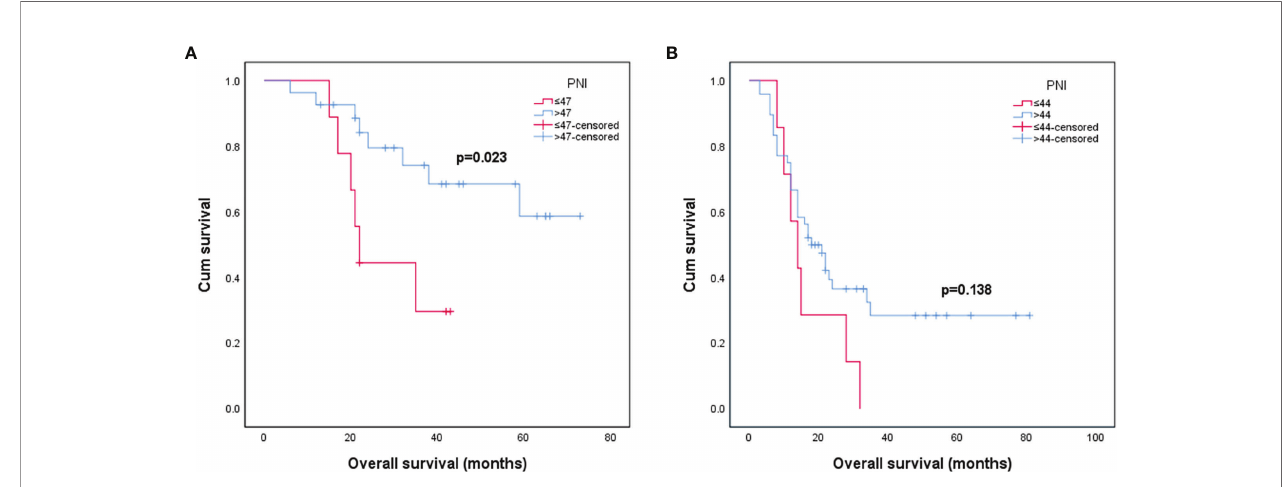
FIGURE 1 | Kaplan – Meier survival curves for patients strati fi ed based on preoperative PNI in patients with grade III glioma (A) and patients with grade IV glioma (B) . (PNI, prognostic nutritional